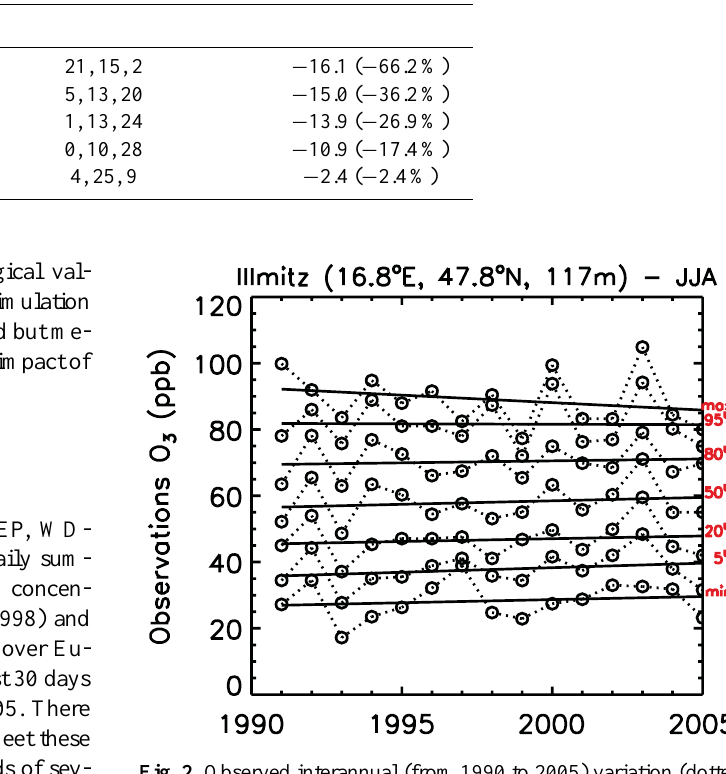
Fig. 2. Observed interannual (from 1990 to 2005) variation (dotted lines) and linear trends (solid lines) in several percentile populations of the summertime O 3 concentrations for the station of Illmitz, in